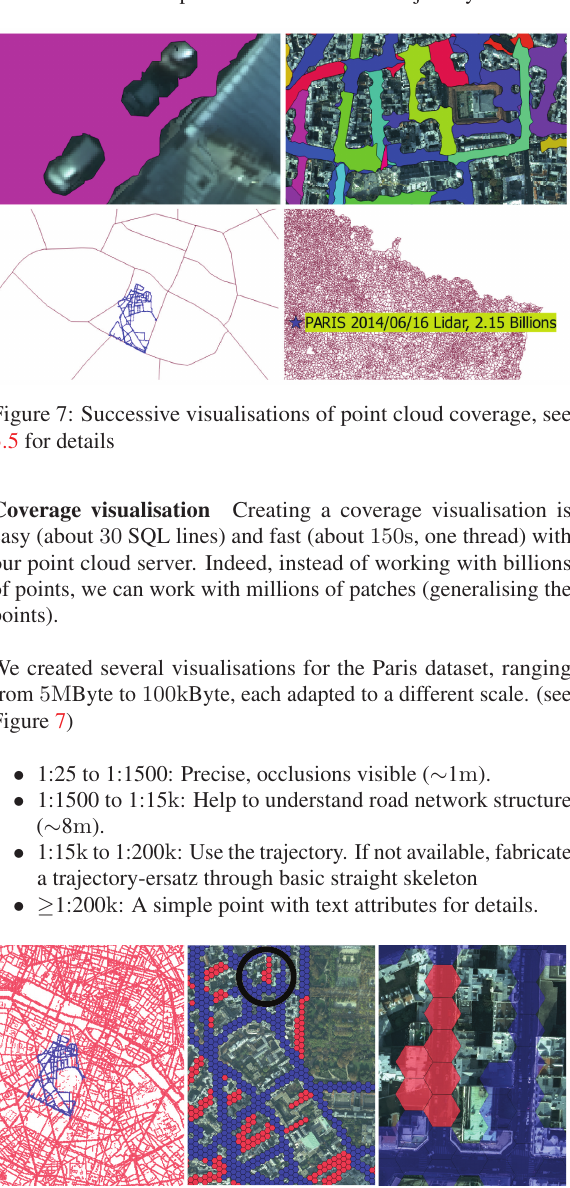
Figure 8: Visualisation of to-do hexagonal map. Blue when sens- ing data, red